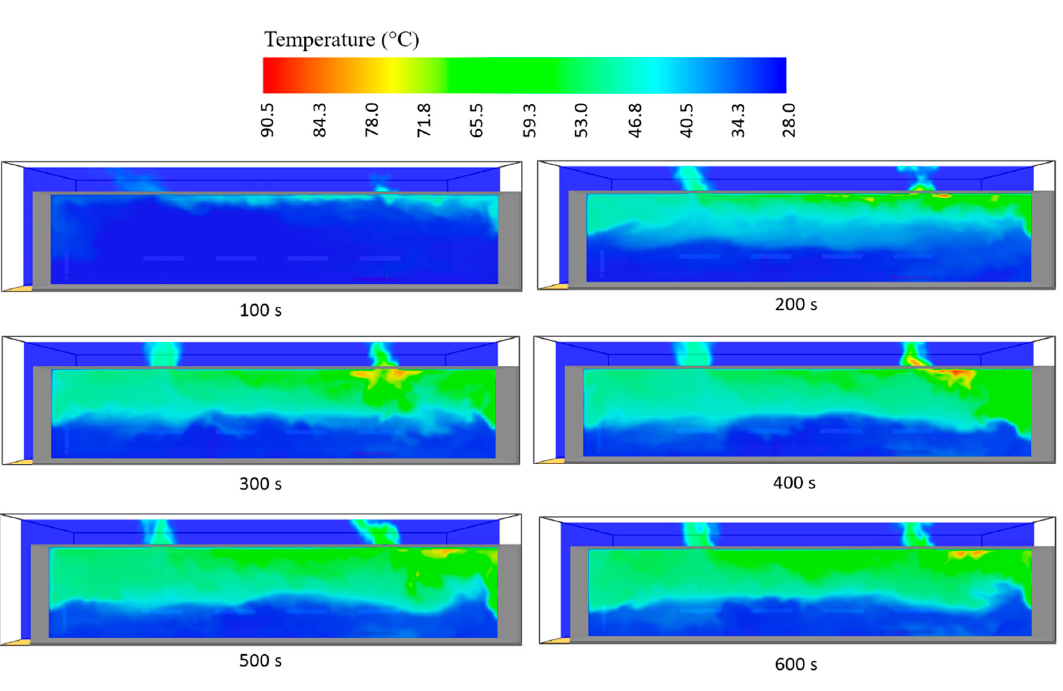
Figure 7. Influence of the natural exhaust area in the ( a ) smoke layer vertical displacement; ( b ) average temperature profile at t = 600 s; ( c ) average exhaust volumetric flow rate and ( d ) HRR (compartment with open windows and HRR = 900 kW).